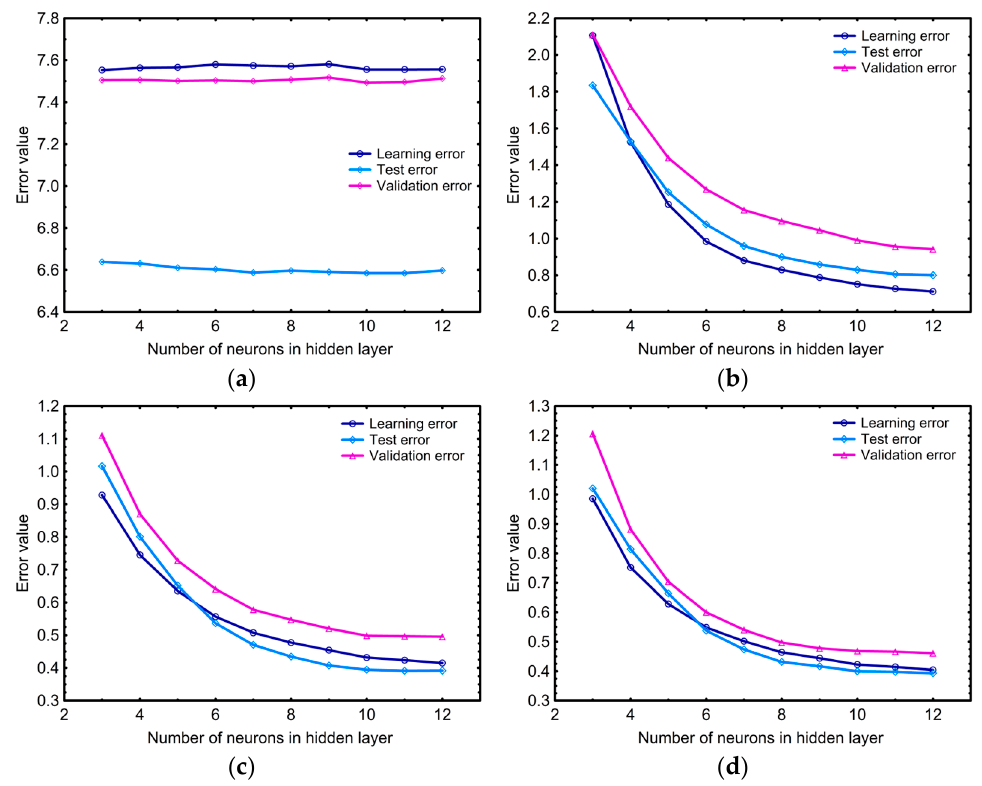
Figure 9. Changes in mean values of training, test, and validation errors of MLP networks applied to modelling of C. freundii population growth and 1,3-PD production depending on the number of neurons in the hidden layer equipped with an activation function in form of ( a ) a linear (Lin), ( b ) an exponential (Exp), ( c ) a logistic function (Log), and ( d ) a hyperbolic tangent (Tanh).